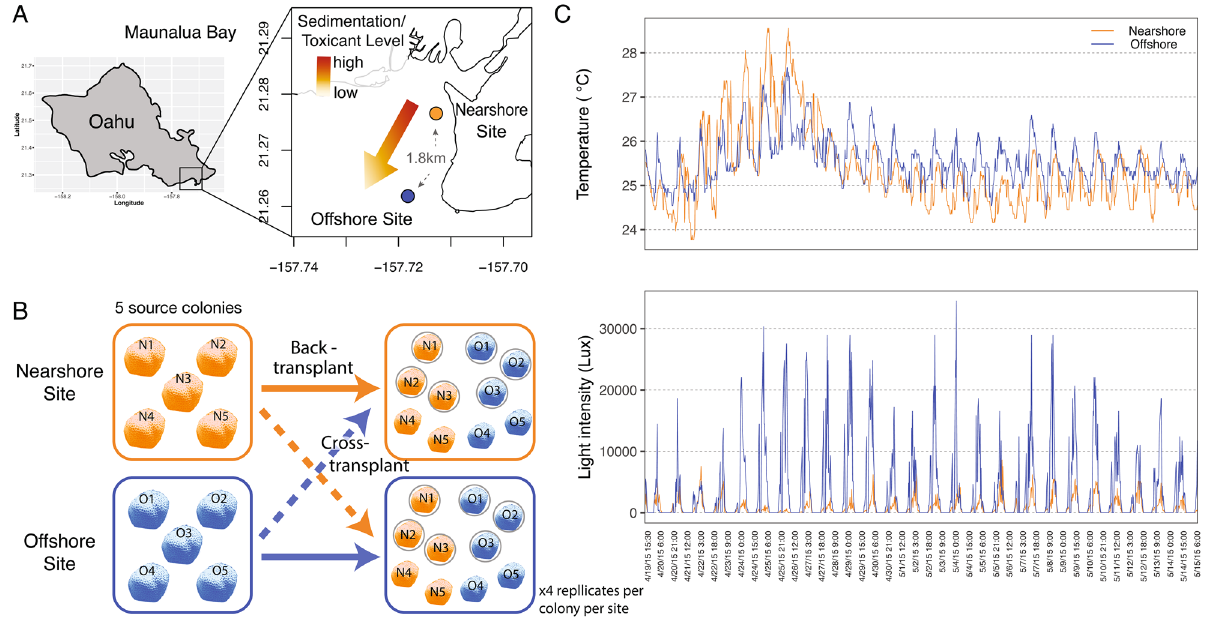
Figure 1. Experimental location and design. (A) A map of study locations, (B) a diagram of the reciprocal transplant experimental design, and (C) temperatures and light intensity profiles during the reciprocal transplant experiment of N- and O-sites. N-site is located in the inner bay where it receives direct run-off, while O-site is located at the end of the bay, exposed to offshore currents with its environmental conditions closer to those of the offshore, despite its proximity to the shoreline (for detailed water quality profiles, see 8,10 ).Gray circles in (B) reflect the three colonies used for proteomic analysis. The map was generated using maptools (v. 1.0-1) package in R 60